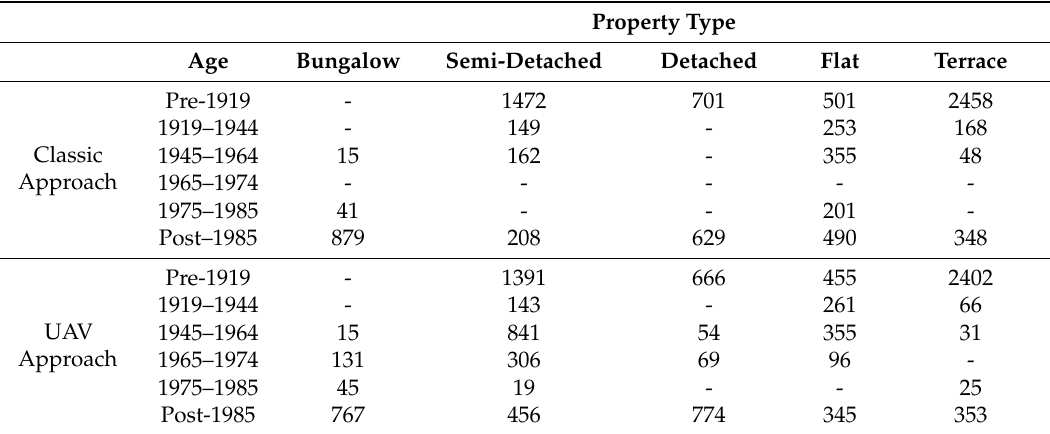
Table 4. Direct tangible loses (£) for residential properties identified as flooded in Cockermouth after Desmond (5–6 December 2015) based on the two loss adjustment approaches considered. The losses (without VAT or other indirect taxes) are in GBP at 2016/17 prices. Calculations assume no resilient/resistance measures were in place. Values reported are in thousands of pounds.